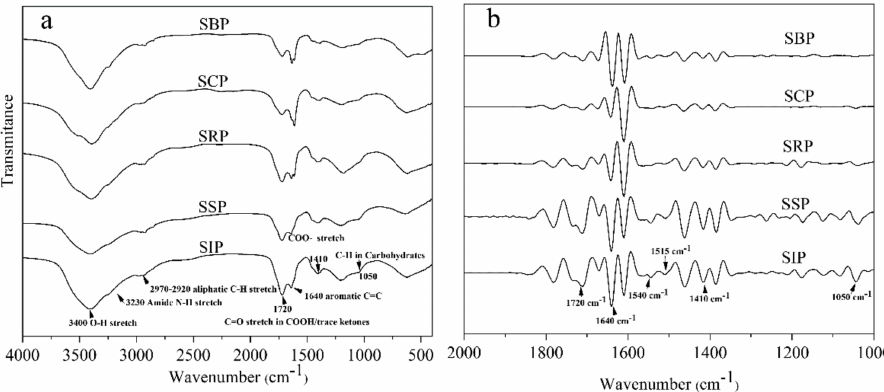
Figure 3. The FTIR spectra of DOM samples isolated from the solar pond process ( a ), and their corresponding second derivative spectra ( b